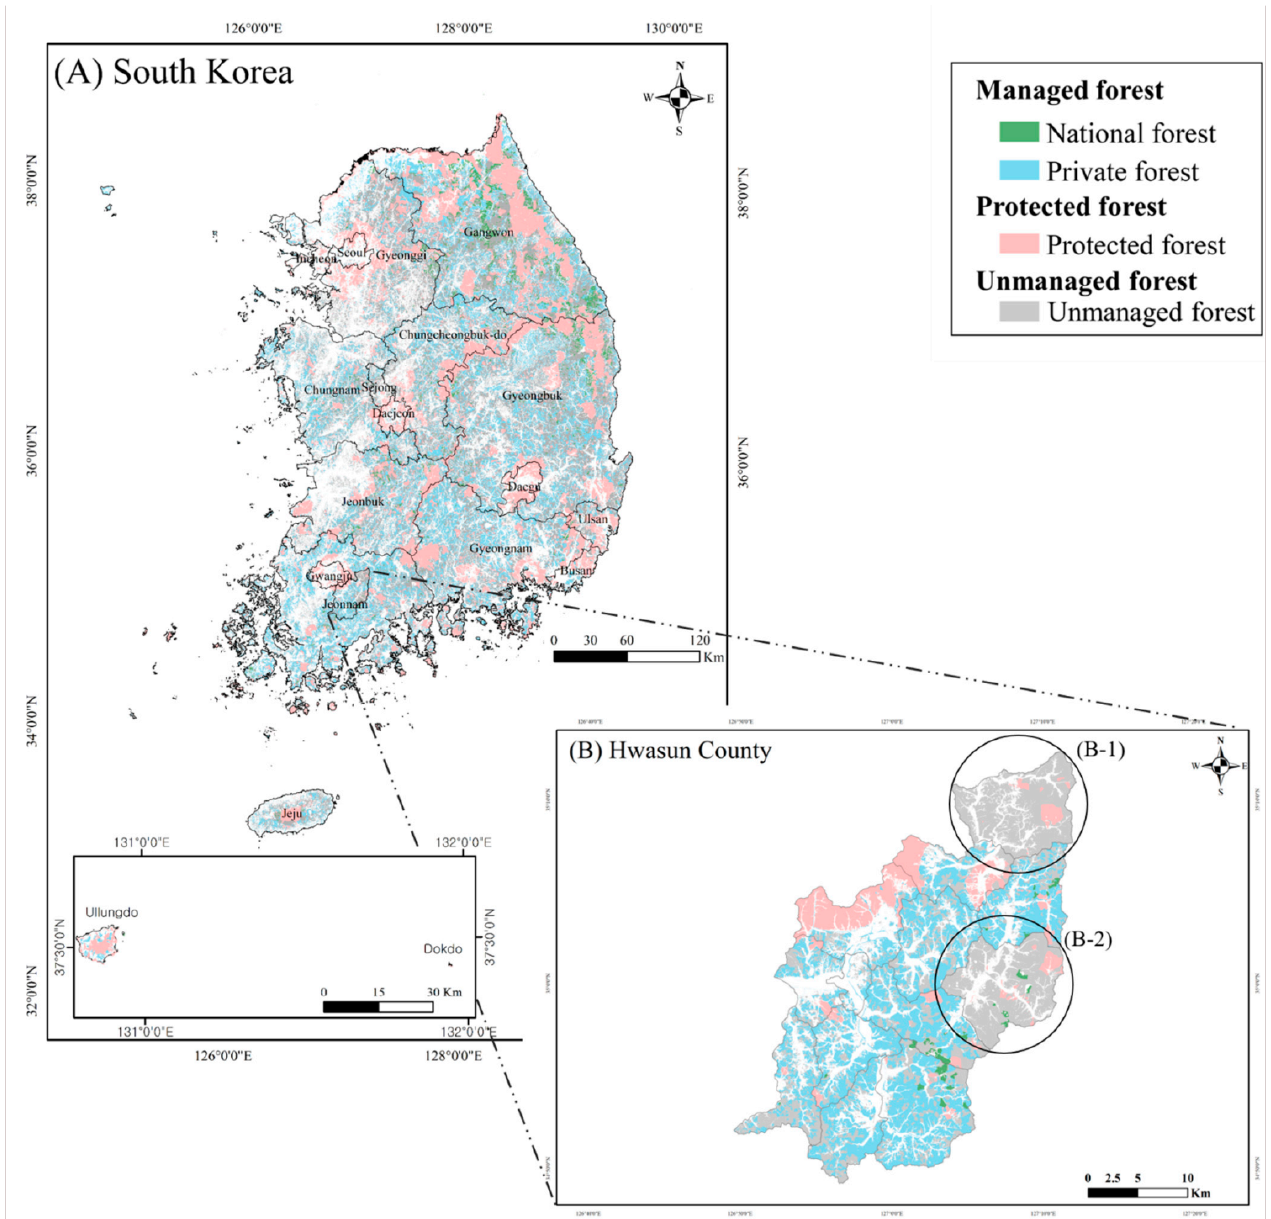
Figure 3. ( A ) Distribution of managed forest areas in South Korea; ( B ) enlarged map of forest management areas in Hwasun County as an example. (B-1) and (B-2) show where the data loss of management activities in privately owned forests has